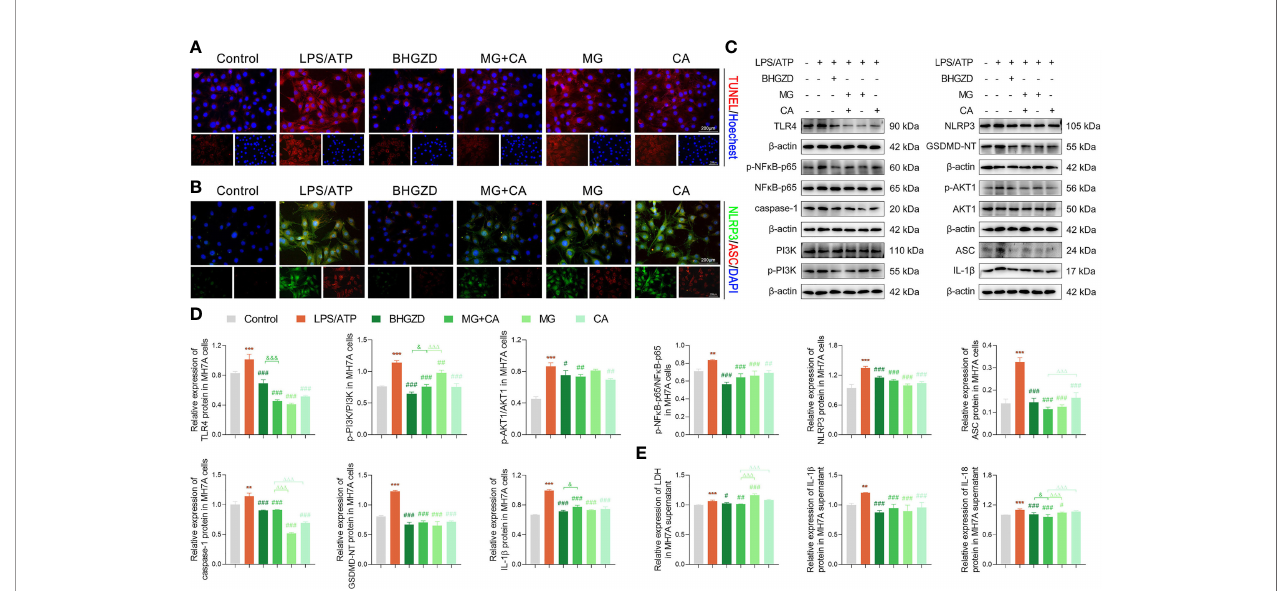
FIGURE 6 | BHGZD inhibits LPS/ATP-induced pyroptosis in MH7A cells by downregulating TLR4, p-PI3K/PI3K, p-AKT1/AKT1, p-NF k B-p65/NF k B-p65, NLRP3, ASC, caspase-1, GSDMD-NT, IL-1 b , and IL-18 (Control, AIA-M, BHGZD, MG+CA, MG, and CA). (A) TUNEL staining of MH7A cells (scale bar represents 200 m m, TUNEL red, Hoechst blue). (B) Expression of NLRP3 and ASC protein measured by immuno fl uorescent staining and confocal microscopy in MH7A cells (scale bar represents 200 m m, NLRP3 FITC green, ASC CY3 red, DAPI blue). (C, D) Expression levels of TLR4, p-PI3K/PI3K, p-AKT1/AKT1, p-NF k B-p65/NF k B-p65, NLRP3, ASC, caspase-1, GSDMD-NT, and IL-1 b in MH7A cells measured by Western blotting ( n = 3 per group). (E) Levels of IL-1 b , IL-18, and LDH release in MH7A cells evaluated by ELISA ( n ≥ 3 per group, all experiments were performed in triplicate). **, ***, p < 0.01, p < 0.001, respectively, comparison with the normal control group; #, ##, ###, p < 0.05, p < 0.01, p < 0.001, respectively, comparison with LPS/ATP-induced model; &, &&&, p < 0.05, p < 0.001, comparison with the treatment of BHGZD; △△△ , p < 0.001, comparison with the treatment of two-BAC